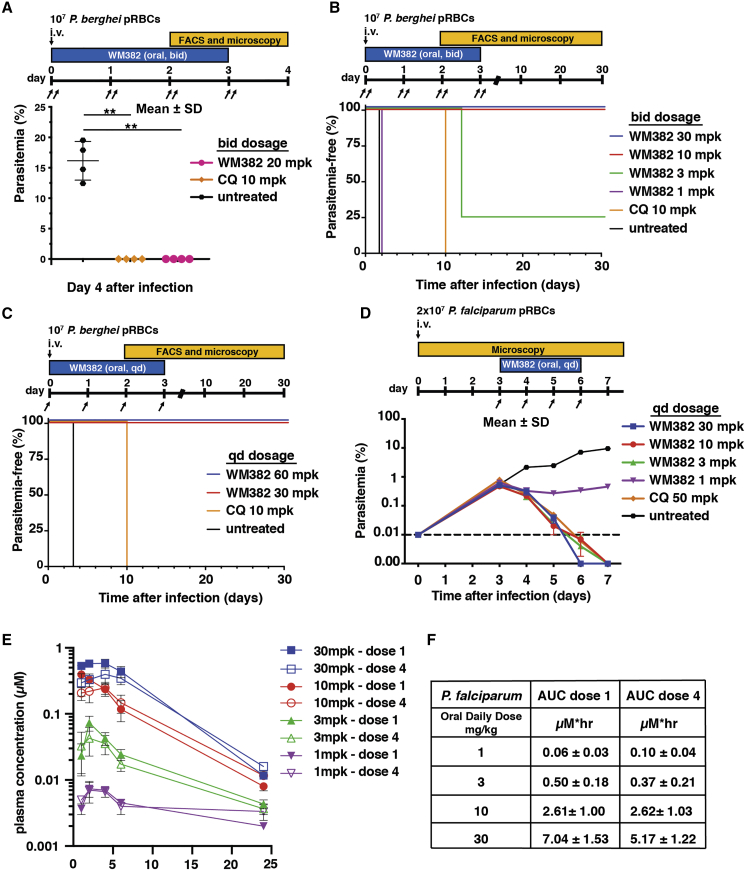
WM382 Cures Mice of P. berghei and P. falciparum Infection(A) WM382 suppresses P. berghei infection, orally administered twice daily (b.i.d. dosage) for 4 days (n = 4). WM382 (20 mpk) compared with 10 mpk chloroquine (CQ). ∗∗p < 0.005: Mean ± SD.(B) P. berghei infected Swiss mice are cured with oral WM382. Mice (n = 4) treated for 4 days (b.i.d.) with WM382 (mpk) or chloroquine (10 mpk).(C) P. berghei infected mice (n = 4) cured with single, oral, daily doses (q.d.) of WM382.(D) Humanized NOD-scid IL2Rγnull mouse model shows WM382 suppresses P. falciparum infection. Mice (n = 3), orally treated for 4 days (q.d.) with WM382 (mpk) or chloroquine (50 mpk). Mean ± SD.(E and F) Concentration of WM382 at 1, 2, 4, 6, and 24 h post first and last drug administration in blood from huSCID mice determined by LC-MS/MS, and (F) corresponding AUC values. Mean ± SD. Parasitemia monitored by fluorescence-activated cell sorting (FACS) and microscopy.